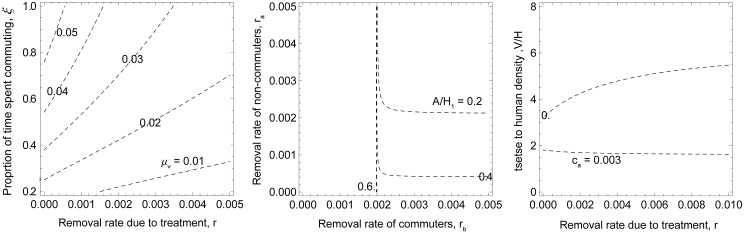
Zero-growth isoclines (R
0 = 1) of T.b. gambiense under perturbation of specific parameters.The parameter values used were the median values obtained for the high transmission setting, except for those varied in the analysis. In the left plot, isoclines at different levels of vector mortality are shown, depending on the daily removal rate of infected humans (r) and the proportion of time commuters spend in the high exposure area (ξ). The areas above the isoclines represent values of R
0 greater than 1, and below and to the right of the isoclines values smaller than 1. In the middle plot the impact of screening humans in the low risk setting (r
a) in combination with screening commuting humans (r
b) is shown for different levels of animal to human ratios (A/H1). In the right plot isoclines are depicted along removal rates (r) and tsetse density (V/H) in both areas when animals either do not contribute to transmission (c
a = 0) or they can infect tsetse (c
a = 0.003).